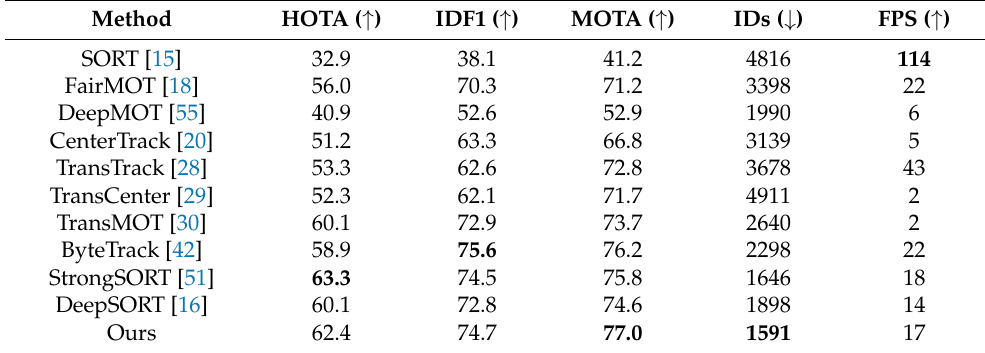
Table 2. Comparison with state-of-the-art MOT methods on the MOT17 test set (YOLOv7).